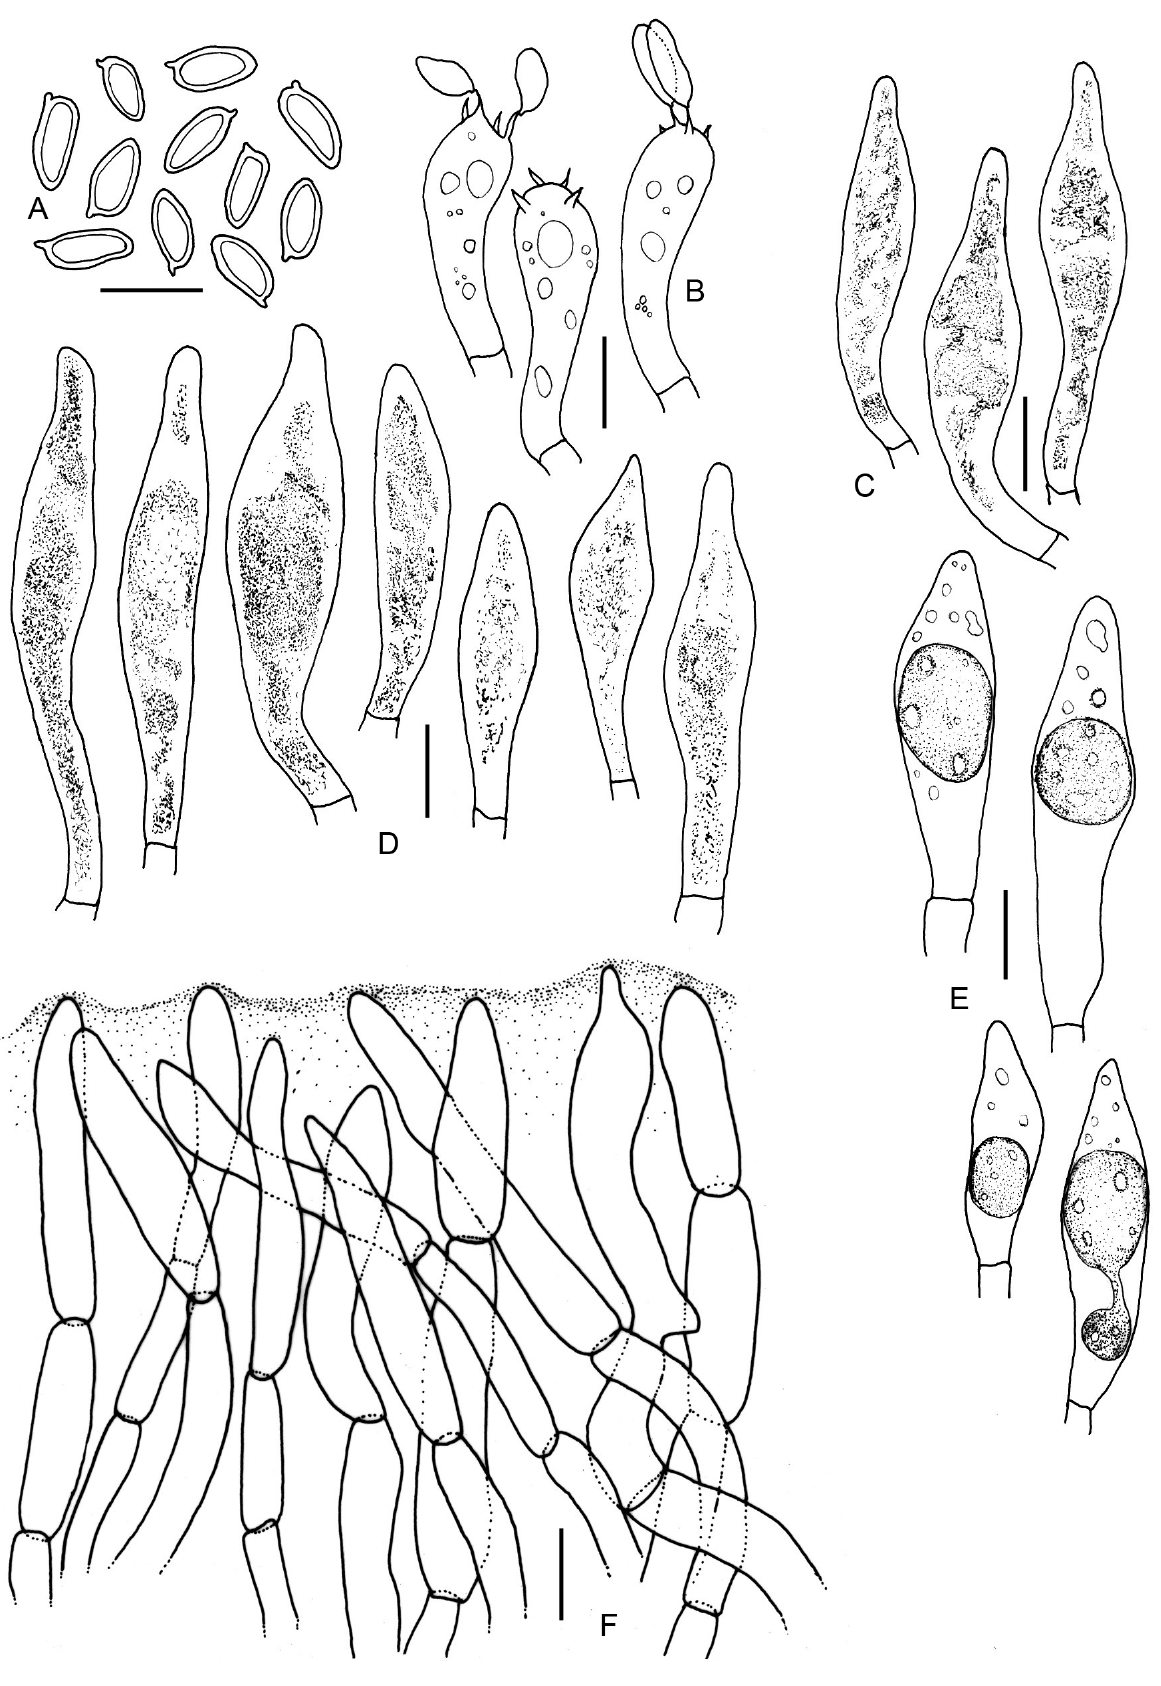
Figure 4. Tylopilus glutinosus . A. Basidiospores. B. Basidia. C. Cheilocystidia. D. Pleurocystidia. E. Caulocystidia. F. Cross section through pileipellis. Scale bars = 10